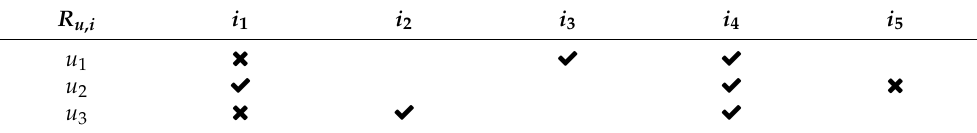
Table 1. Rating matrix used in the running example. Rating values are: like ¸ and dislike Ø . R u , i